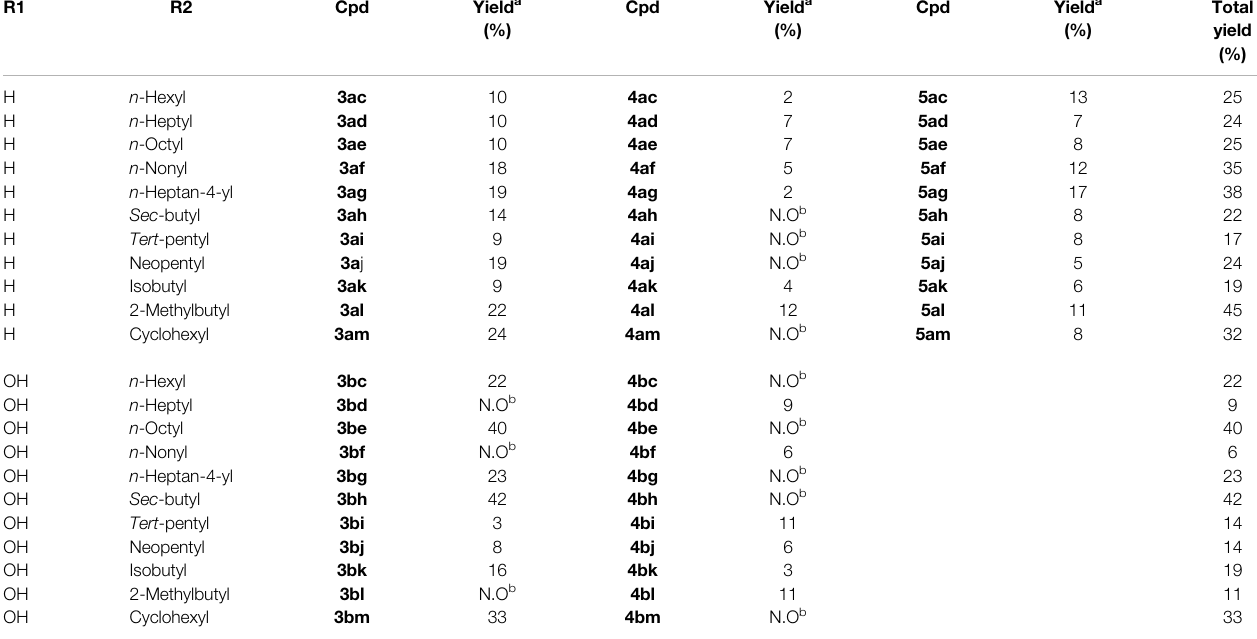
TABLE 1 | Chemical structure and yields of synthesized